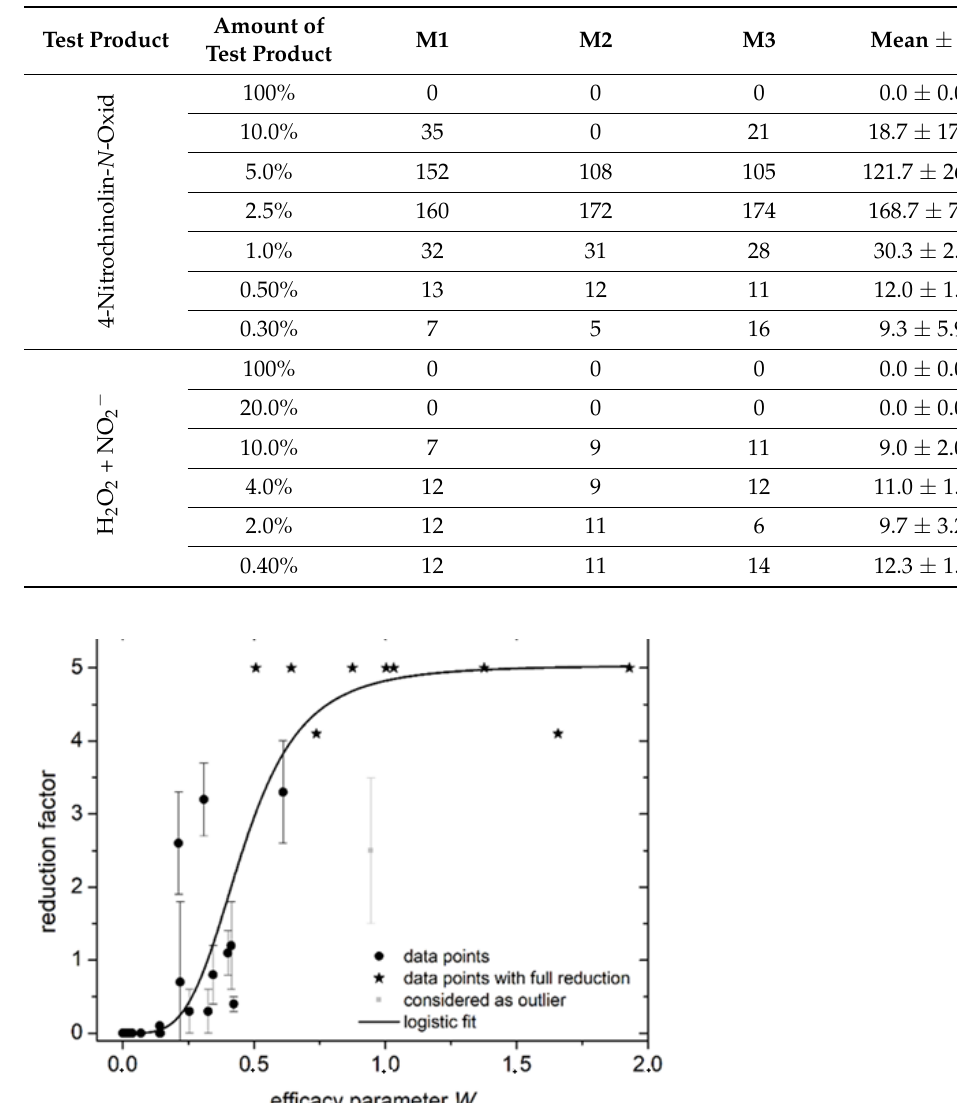
Table 2. cfu per plate of individual measurements (M1 to M3) after treatment with 4-Nitroquinoline- N -oxide (100% = 100 µ g per plate) or ONOOH-solution (100% = the initial concentration in mixed